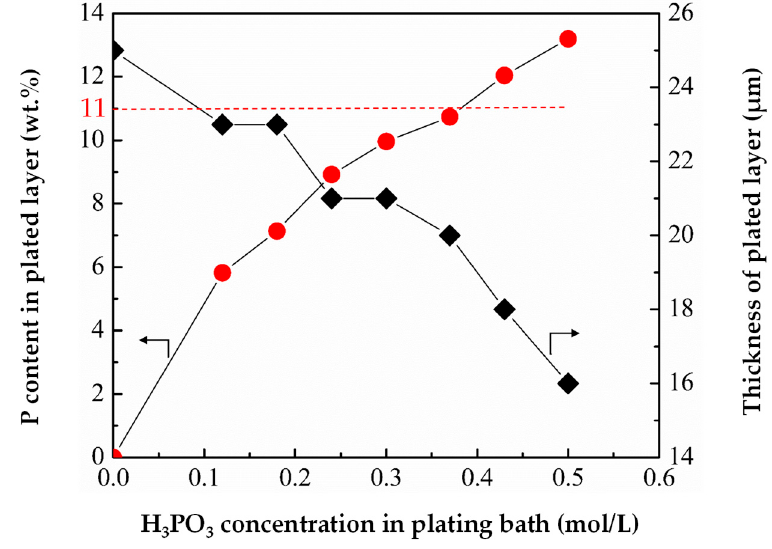
Figure 3. Effect of H 3 PO 3 concentration on P content and thickness of Ni-P plated layer (C.D.: 2.0 A/dm 2 , plating time: 90 min).